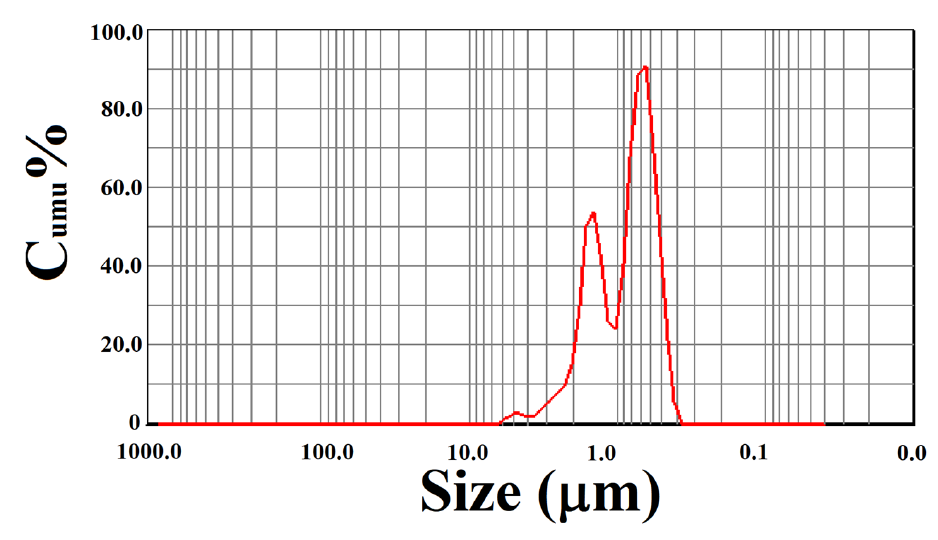
Figure 3. The results show that grain sizes range from 300 nm to 6000 nm.